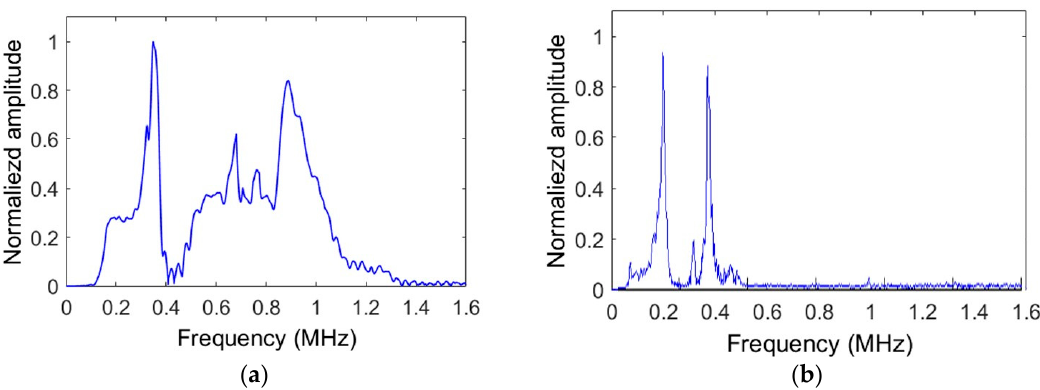
Figure 5. Response in reception of the sensor μ 80 ( a ) and R15 ( b ) experimentally obtained using the reciprocity method.